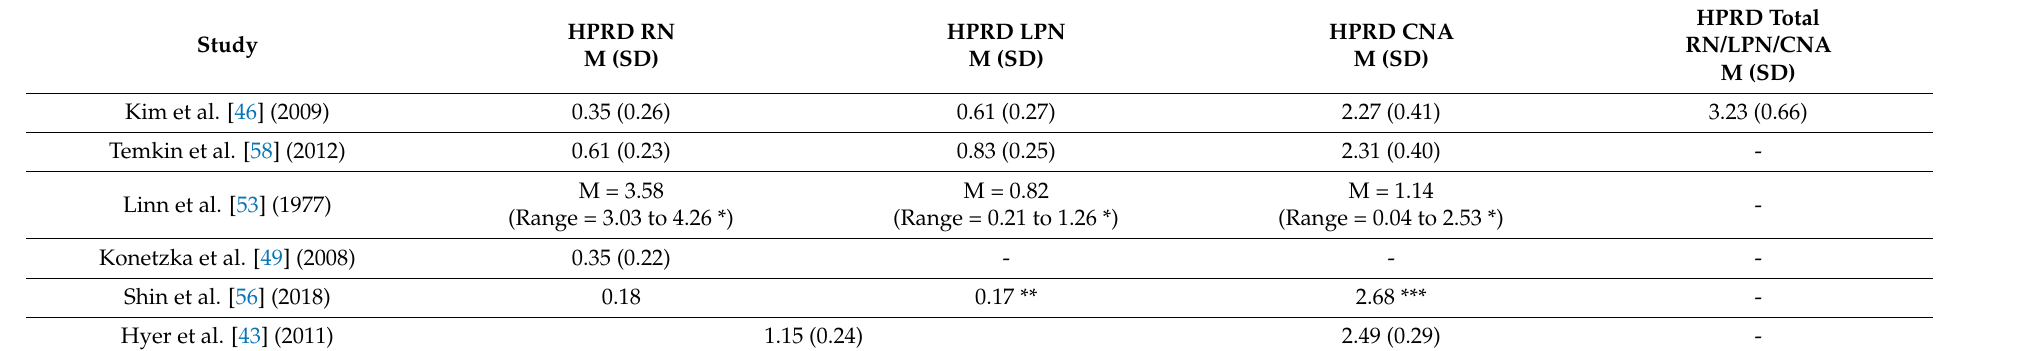
Table 3. Synthesis of the